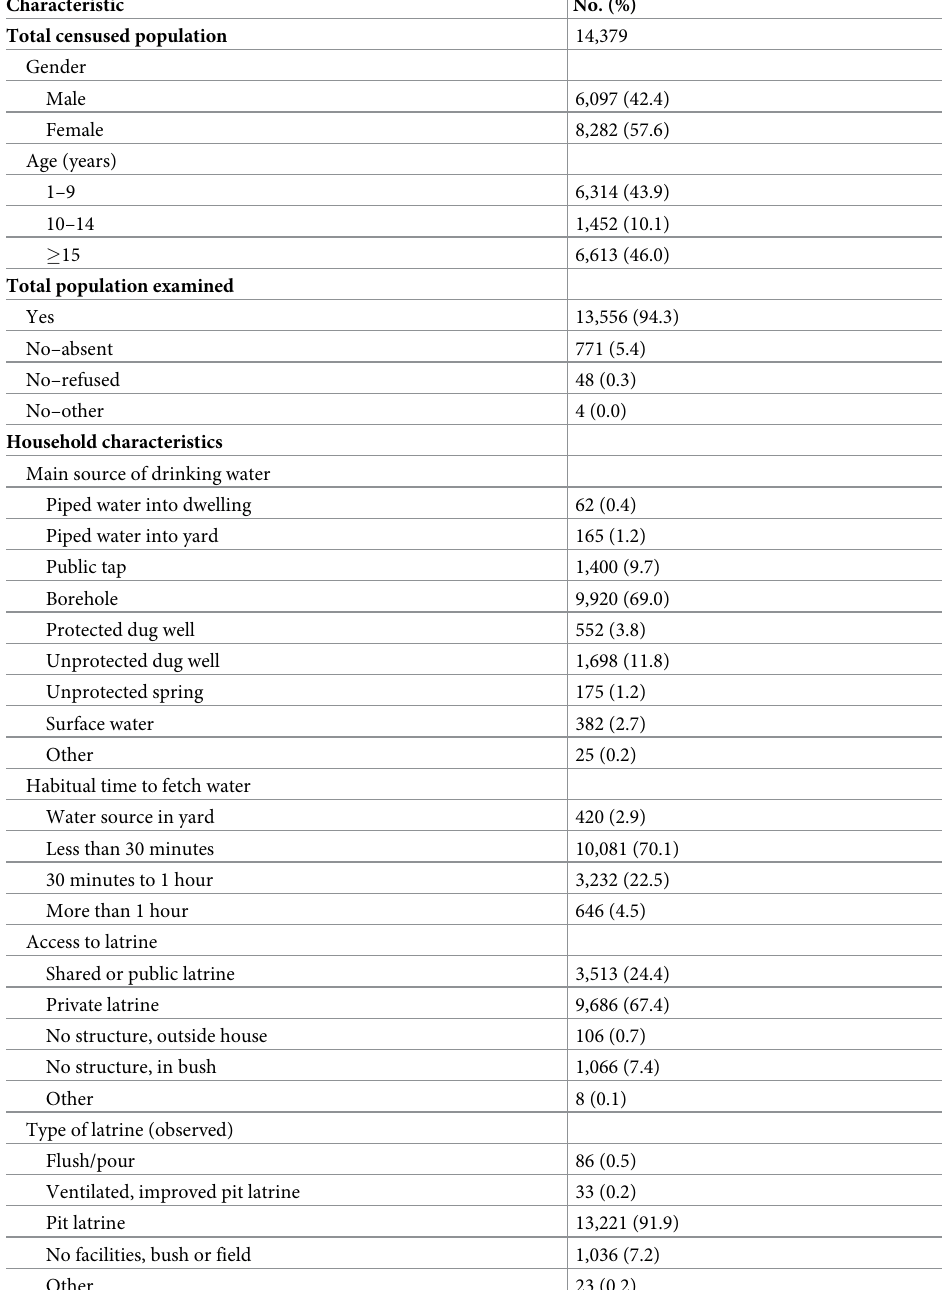
Table 1. Characteristics of study